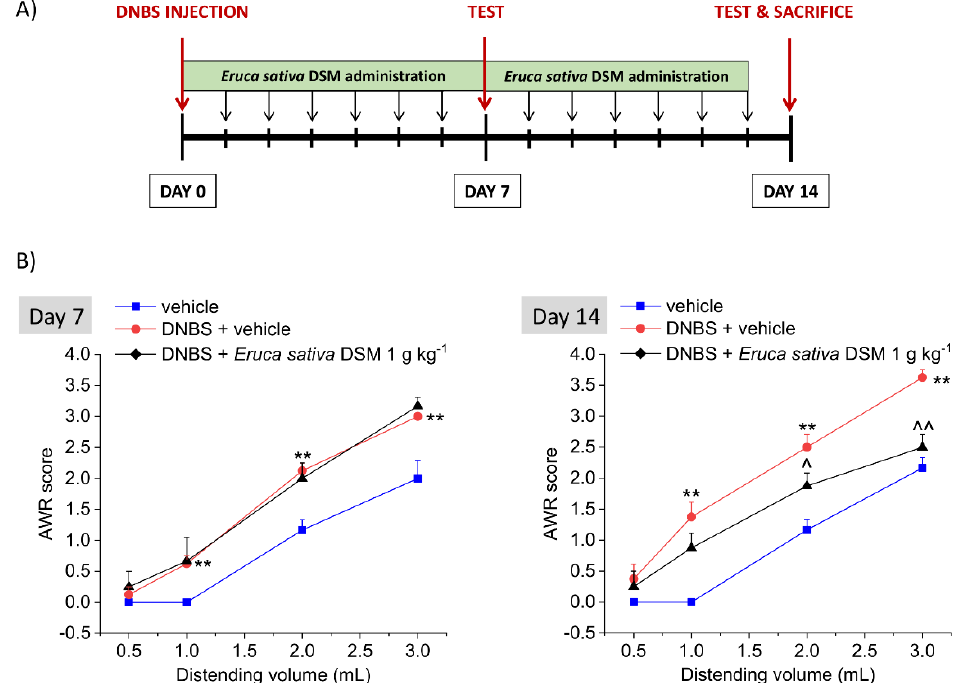
Figure 4. The effect of the repeated treatment with Eruca sativa DSM on visceral pain induced by colitis in rats. Experimental scheme ( A ); Visceral sensitivity was assessed in animals by measuring the extent of the abdominal withdrawal response (AWR) to colorectal distension, carried out by applying an increasing distending stimulus on the colon walls (0.5–3 mL). Eruca sativa DSM (1 g kg − 1 ) was administered once daily in the DNBS-treated animals, starting from the day of DNBS injection for 14 consecutive days and pain threshold was assessed on day 7 (acute inflammatory phase) and 14 (post-inflammatory phase) ( B ). Each value represents the mean ± SEM of 6 animals per group. ** p < 0.01 vs. vehicle. ^ p < 0.05 and ^^ p < 0.01 vs. DNBS + vehicle. The treatment with E. sativa DSM (1 g kg −1 ) significantly counteracted the consolida- tion of visceral hyperalgesia in the post-inflammatory phase of colitis induced by DNBS (Figure 4B, day 14), though it was ineffective in preventing the establishment of pain caused by the acute inflammatory damage in the same animals (Figure 4B, day 7). Indeed, on day 14, animals receiving DNBS + E. sativa DSM showed a significantly lesser AWR than those treated with DNBS + vehicle when 2- and 3-mL stimuli were applied (Figure 4B, day 14; p < 0.05 with 2 mL and p < 0.01 with 3 mL), while no difference were observed between DNBS animals receiving the meal or the vehicle on day 7 (Figure